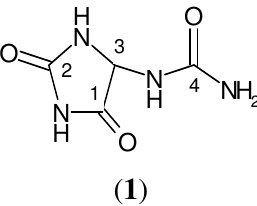
Figure 1. Planar structural formula of